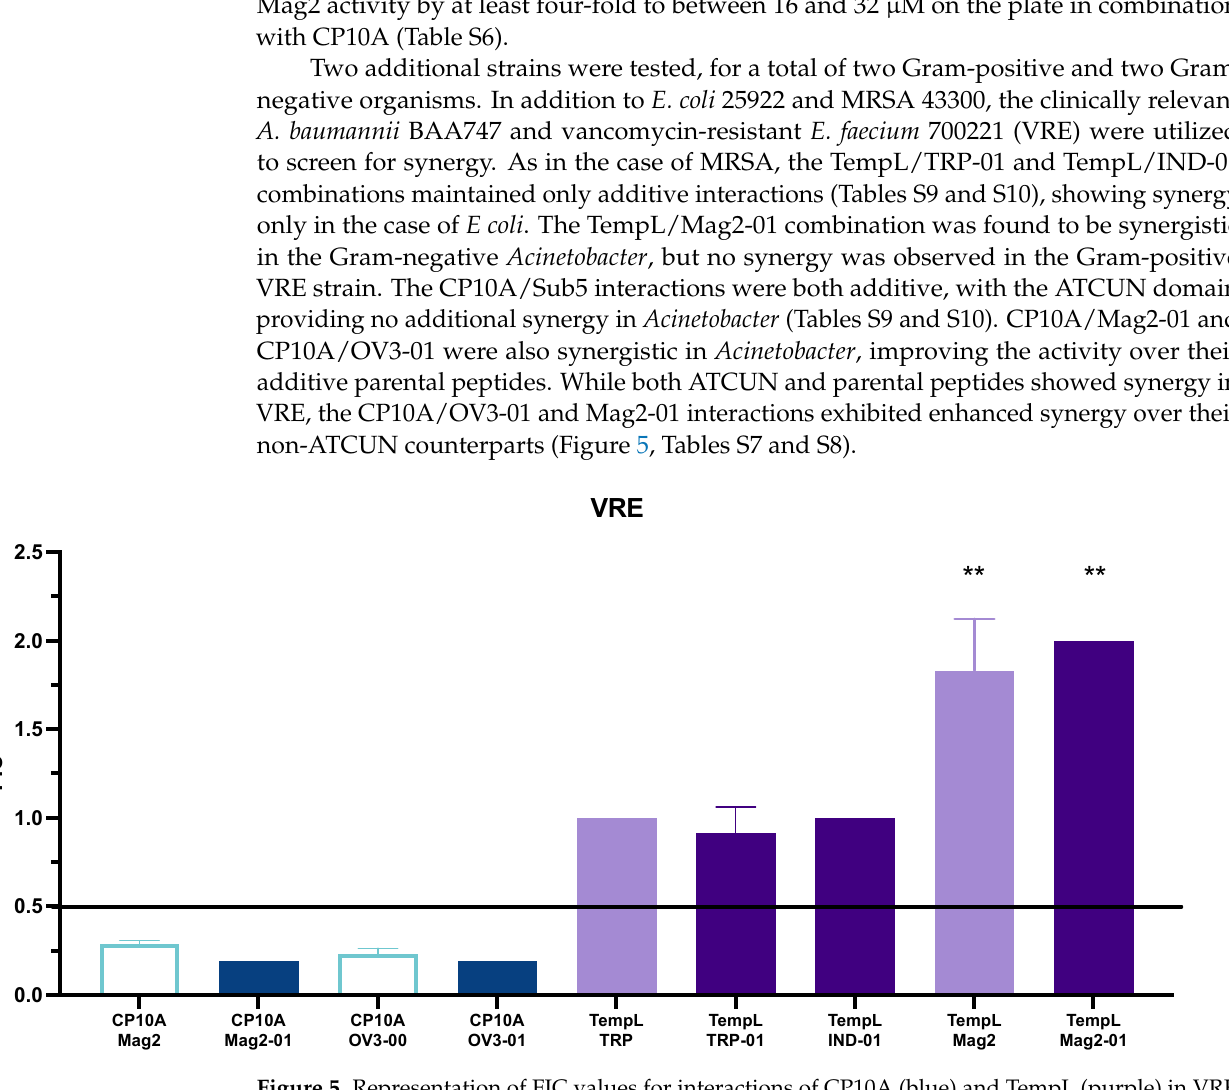
Figure 5. Representation of FIC values for interactions of CP10A (blue) and TempL (purple) in VRE. ATCUN-containing derivatives are represented as dark blue or dark purple, and parental peptides are represented as light blue or light purple. The line at 0.5 represents the threshold for synergy. Data marked (**) indicate biofilm formation, and no detectable MIC was determined for Mag2-01 below 32 µM. Error is reported as the standard deviation of the mean.